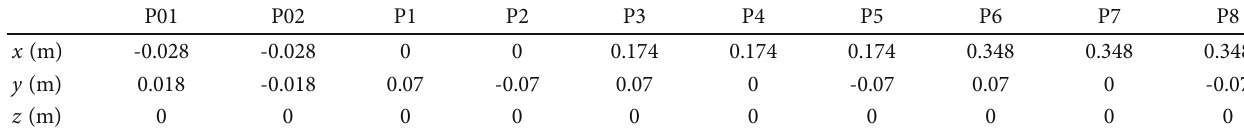
Table 1: The spatial coordinates of all monitoring